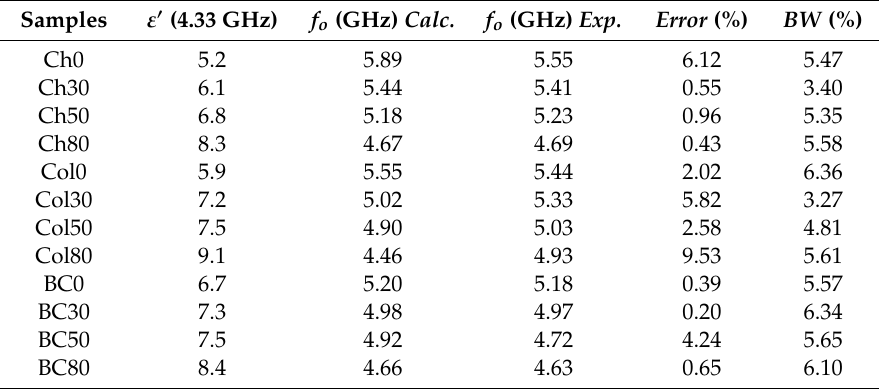
Calculated and experimental operating frequencies and bandwidths for prepared microstrip